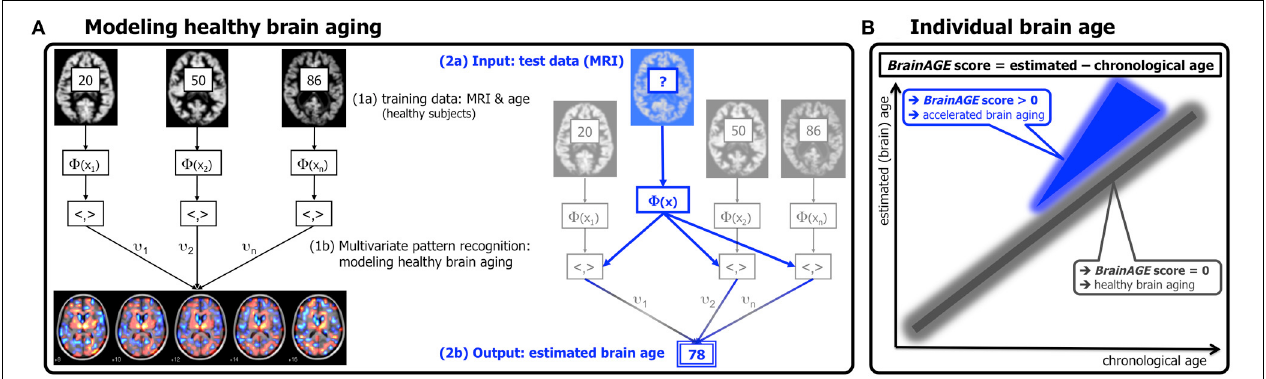
FIGURE 1 | Depiction of the BrainAGE concept. (A) The model of healthy brain aging is trained with the chronological age and preprocessed structural MRI data of a training sample (left; with an illustration of the most important voxel locations that were used by the age regression model). Subsequently, the individual brain ages of previously unseen test subjects are estimated,